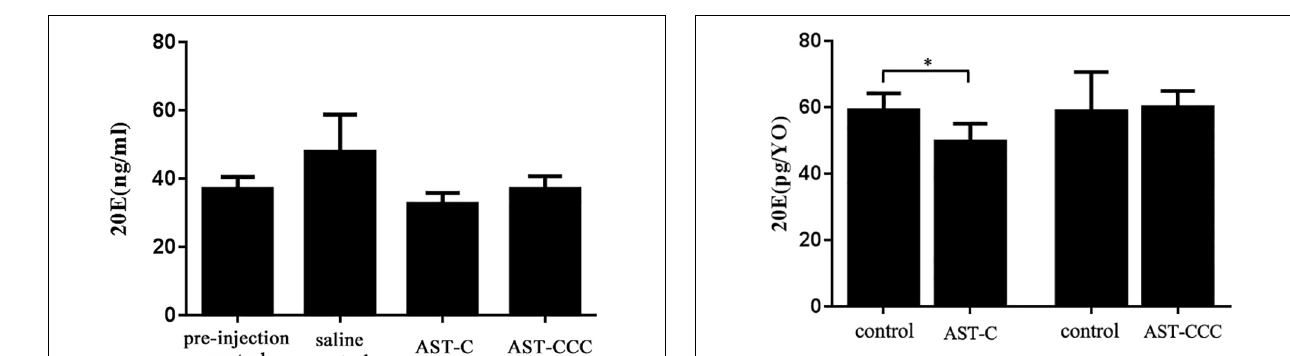
Frontiers in Marine Science |